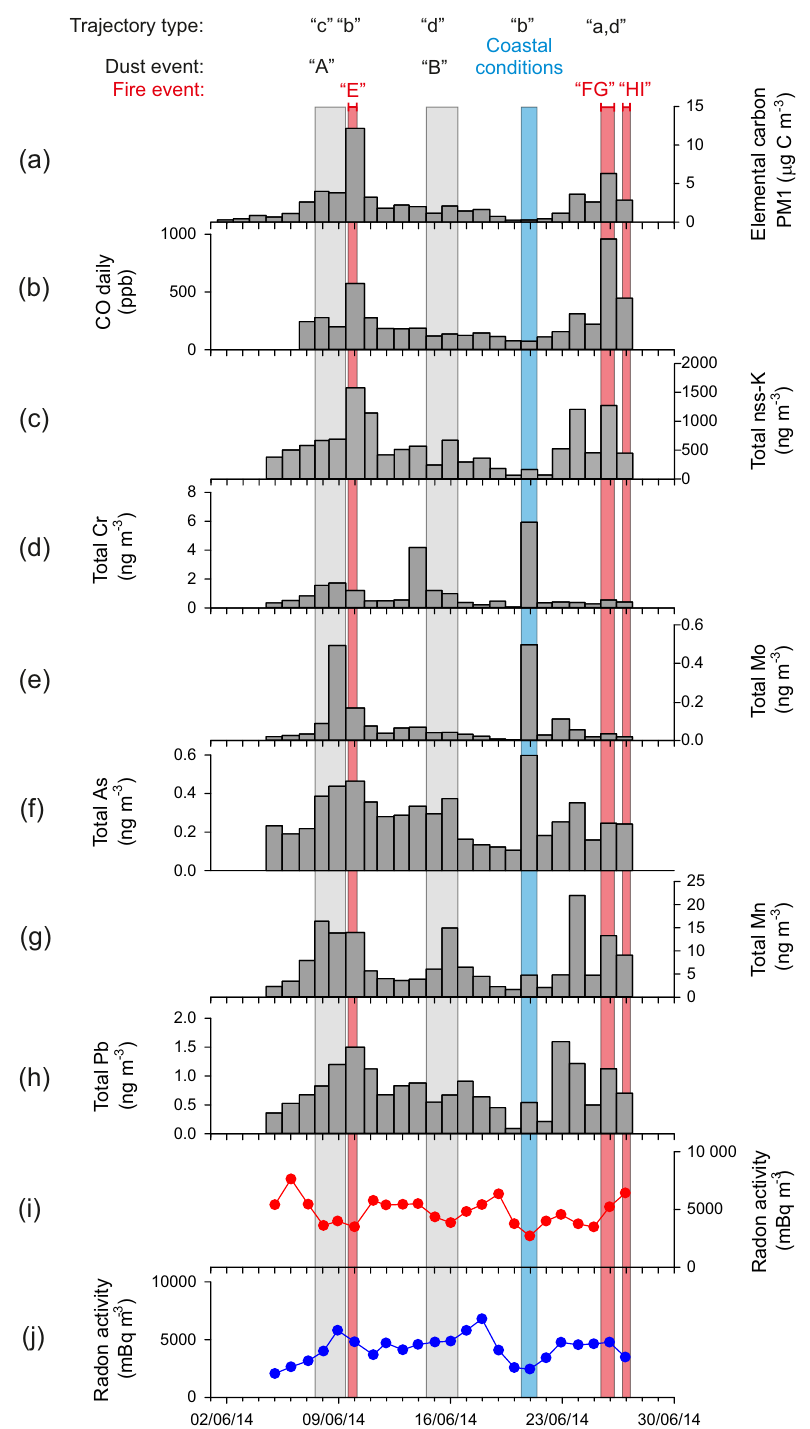
Figure 4. Total trace metal composition of daily aerosol samples influenced by dry season biomass burning at Gunn Point, northern Australia. Time series of (a) elemental carbon concentration; (b) carbon monoxide concentration; PM 10 trace element concentrations of (c) total nss-K, (d) total Cr, (e) total Mo, (f) total As, (g) total Mn, and (h) total Pb; and (i) diurnal radon and (j) advective radon. Fire events, dust events and coastal conditions are highlighted. For trajectory types associated with these periods refer to Fig.